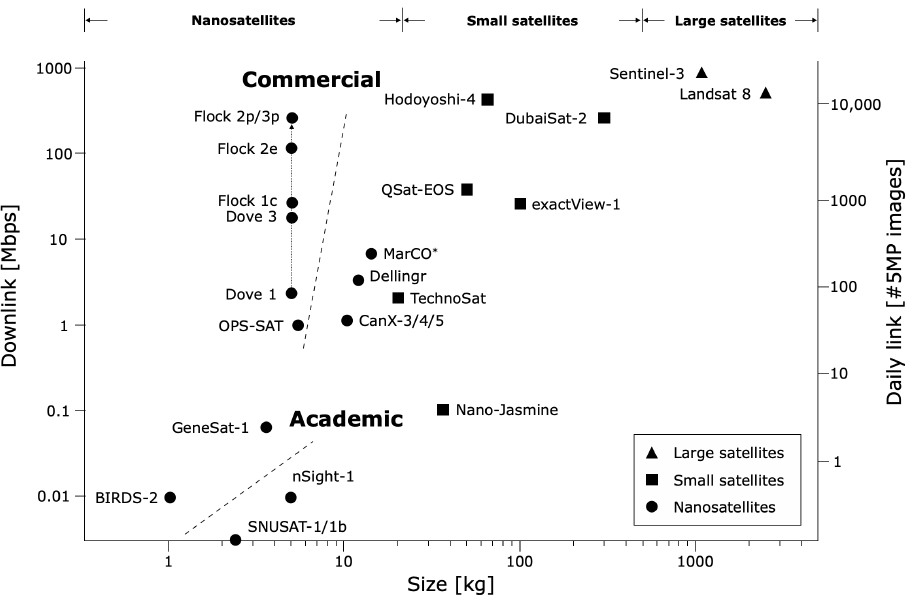
Figure 1. Downlink capability of various spacecrafts. Nanosatellites are limited in downlink data, therefore being able to downlink high priority data is more important compared to larger satellites that have the capability of bulk downlink. The class and downlink information (band, RF power, and downlink throughput) and corresponding references for each satellite are shown in Table 1. Table 1. Detailed information on the downlink capacity of various spacecrafts for Figure 1. (* Maximum achieved in laboratory